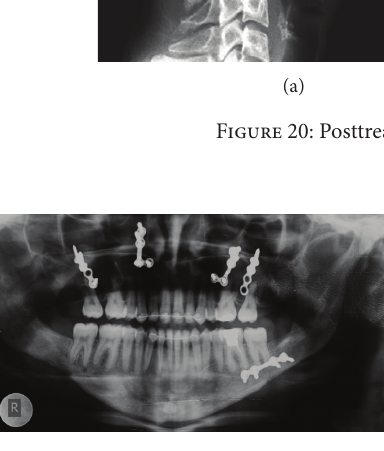
Figure 21: Posttreatment orthopantomogram (OPG).